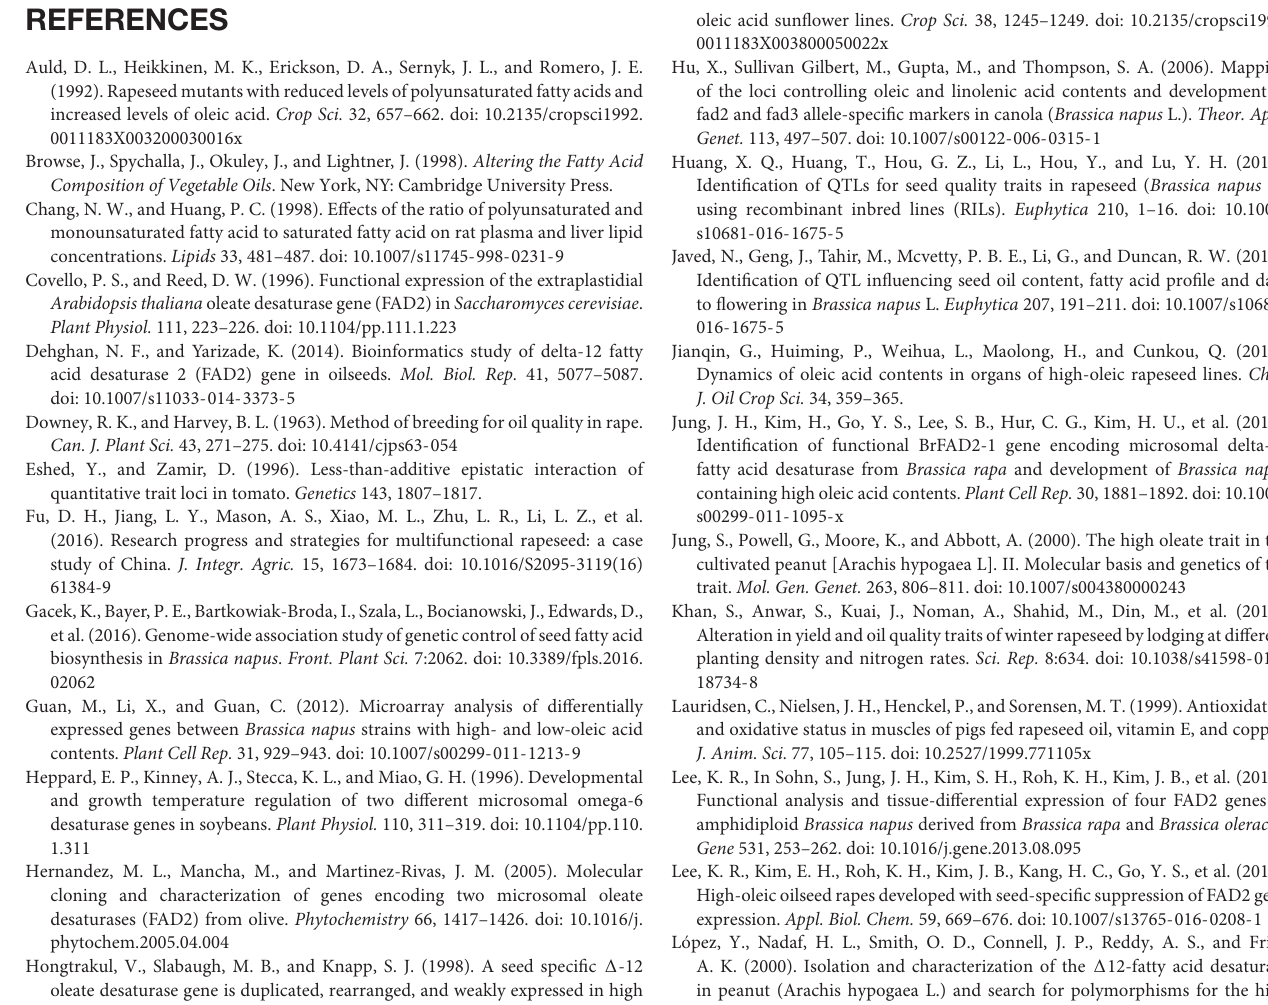
TABLE S4 | Average fatty acid and oil content percentages of each genotype in the parental lines and the segregated populations (F2-2 and BC1-2) at two